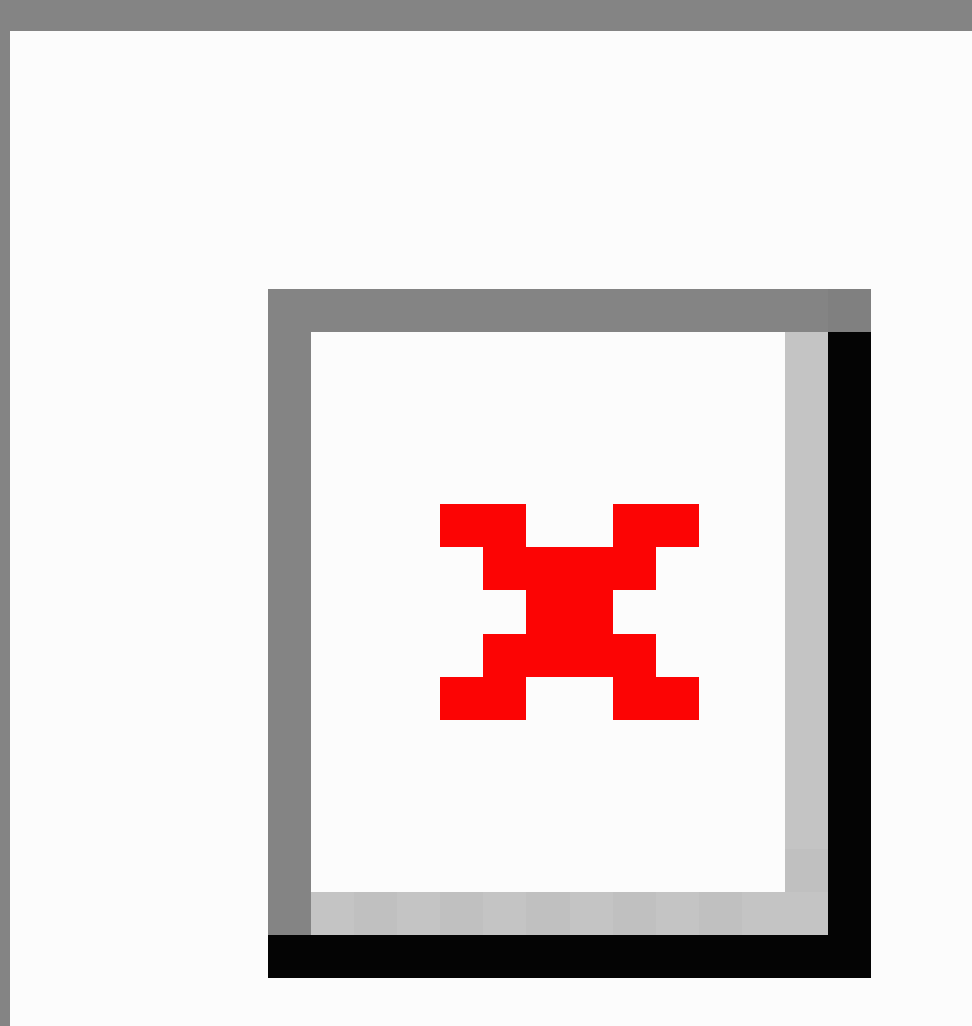
Figure 2. Percent of users who lost at least 5% of initial weight by cumulative enrollment